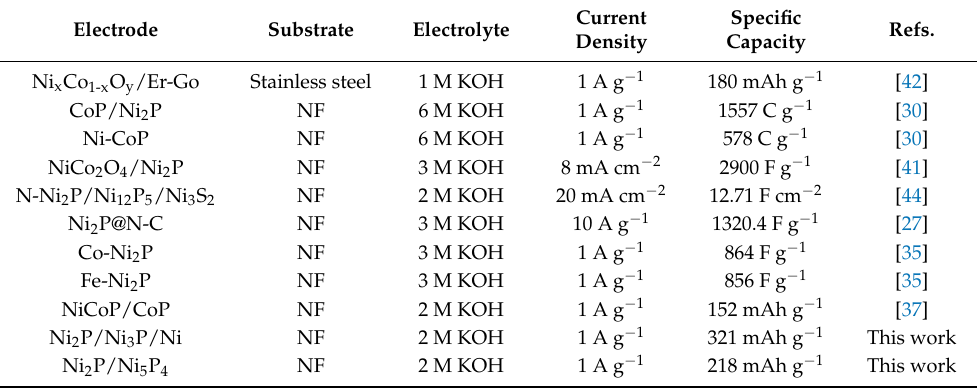
Figure 8. The electrochemical test graph of Ni 2 P/Ni 3 P/Ni (Ni/P = 7:3) and Ni 2 P/Ni 5 P 4 (Ni/P = 5:4). ( a , b ) Galvanostatic charge-discharge curves of Ni 2 P/Ni 3 P/Ni (Ni/P = 7:3) under various current densities and cyclic voltammetry curves of Ni 2 P/Ni 3 P/Ni (Ni/P = 7:3) at various scan rates. ( d , e ) Gal- vanostatic charge-discharge curves Ni 2 P/Ni 5 P 4 (Ni/P = 5:4) under various current densities and cyclic voltammetry curves of Ni 2 P/Ni 5 P 4 (Ni/P = 5:4) at various scan rates. ( c , f ) Cyclic stability test graph of Ni 2 P/Ni 3 P/Ni (Ni/P = 7:3) and Ni 2 P/Ni 5 P 4 (Ni/P = 5:4). Table 3. Comparison of the electrochemical performance of our prepared electrodes with other reported electrode materials in the